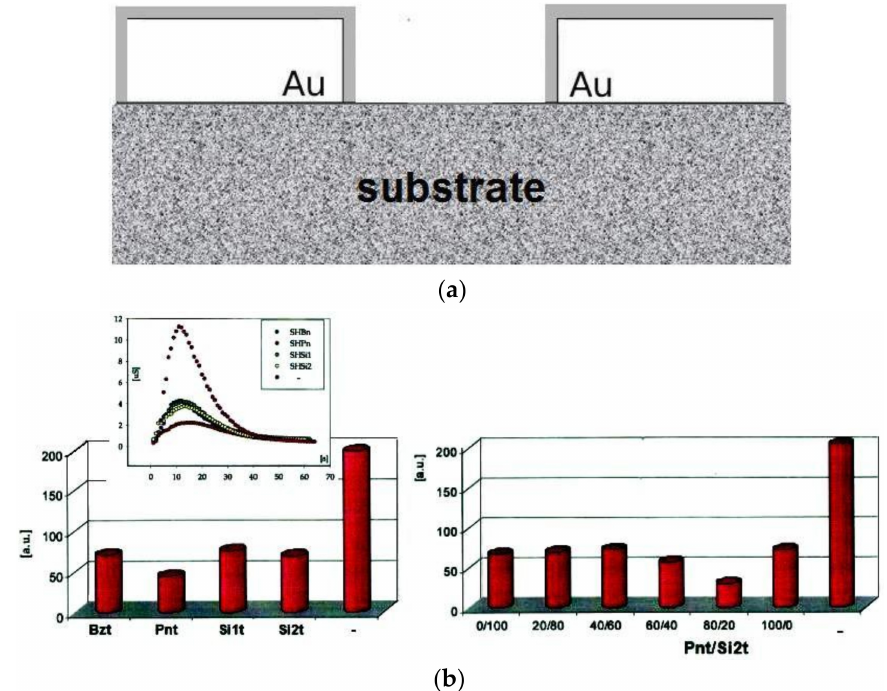
Figure A1. ( a ) A scheme of the system for the preliminary study. The tested blocking monolayer (grey) is formed at the surface of the clean gold electrodes (polyaniline is not deposited in this case) and the current is measured in contact with 0.15 M of NaCl in water; ( b ) the results of the preliminary tests of different blocking layers (with no polyaniline fibers deposited); the integral intensity of the ion current signal (inset), measured in a continuous flow system after the injection of 75 µ L of 0.15 M of NaCl in water, for a series of monolayers of different composition: Bzt—benzyl-1-thiol,